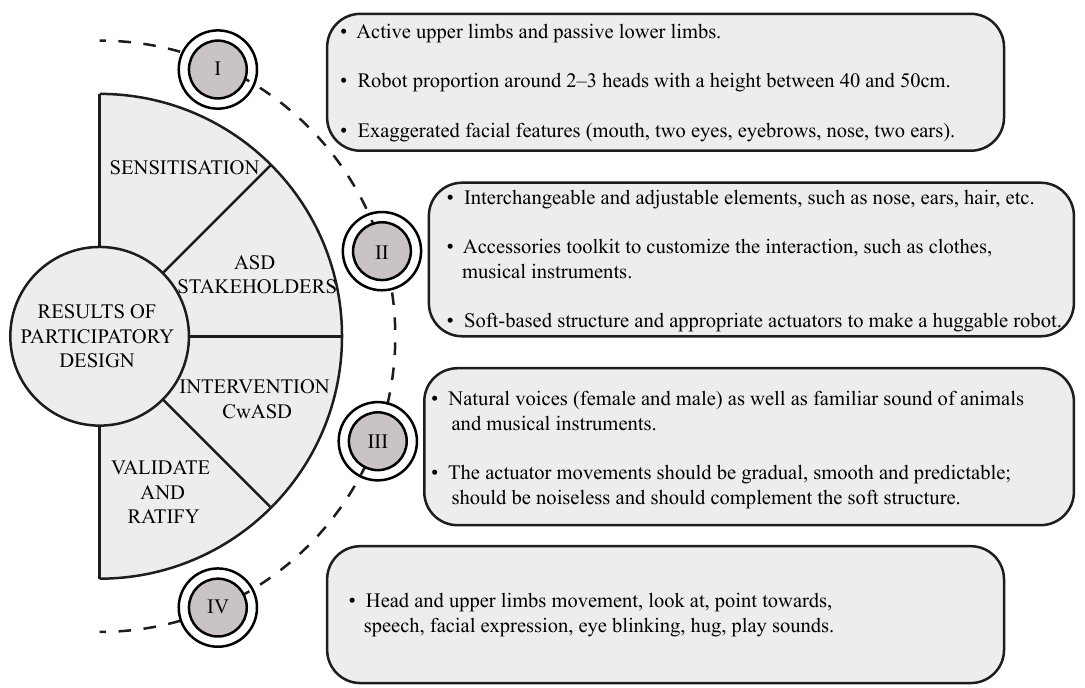
Figure 1. Real prototype and characteristics of the CASTOR robot. Within the robot, the left side shows the outfit, and the right part illustrates the mechanical structure. The measurements on CASTOR refer to the actual sizes.